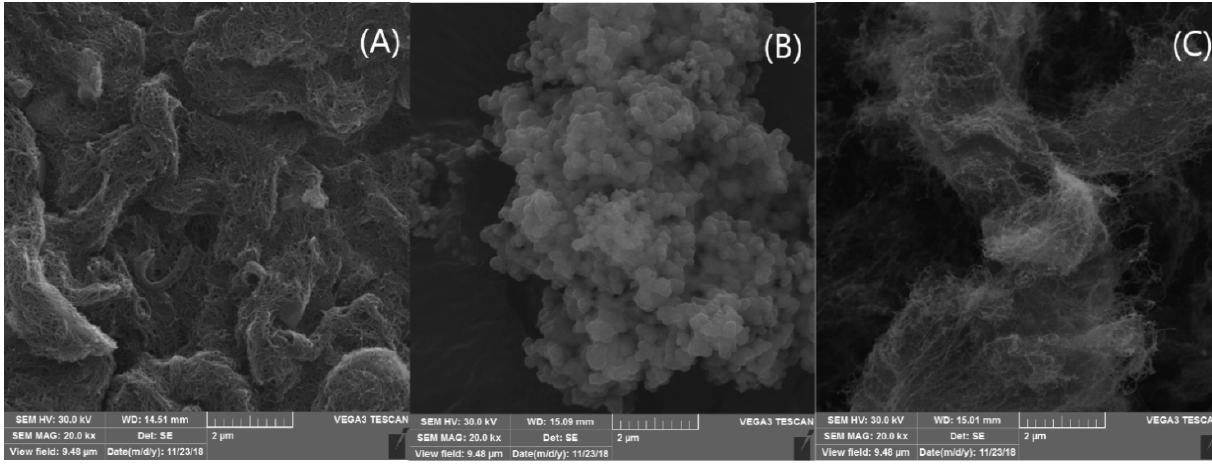
Figure 2. SEM. ( A ) MWCNT ( B ) Fe 3 O 4 @SiO 2 , and ( C ) MWCNT/Fe 3 O 4 @SiO 2 .